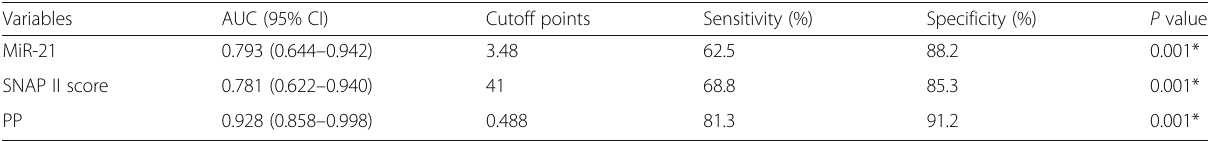
Table 5 Performance characteristics of miR-21 expression (2 −Δ Ct ), SNAP II, and predictive probabilities in sepsis survivors and non-